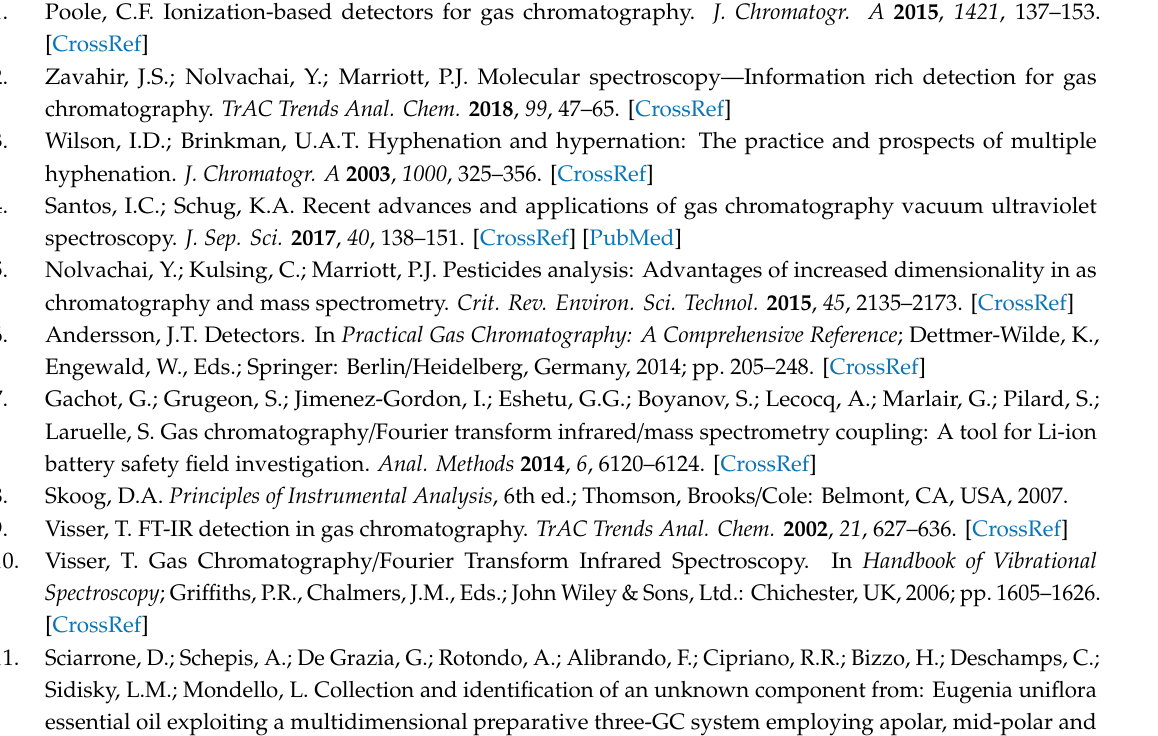
setup schematic for the light-pipe GC–FTIR–FID system., Figure S2: E ff ect of increasing light-pipe (and transfer line) temperatures on the root mean square intensity absorbance of GC–FTIR chromatograms of nonane., Figure S3: E ff ect of increasing LP and TL T , varying FTIR resolution and varying flow on signal-to-noise ratio calculations., Figure S4: GC–FTIR and GC–FTIR–FID chromatograms of 5% o -cresol in MeOH at varying injection volumes of (a) 1.5 µ L, (b) 2.0 µ L and (c) 3.0 µ L., Figure S5: Virtually identical GC–MS spectra for o -, m - and p -cresol isomers and their corresponding GC–FTIR spectra., Figure S6: GC–FTIR spectra of α -pinene, β -pinene, geraniol, γ -terpinene, limonene and eugenol essential oil standard compounds., Figure S7: GC × FTIR colour contour plot of acetaldehyde oxime (A.O.) and propionaldehyde oxime (P.O.) elution with FTIR spectra corresponding to P.O. isomers at di ff erent positions over the dynamic P.O. peak., Figure S8: Calibration curves for peak area of o -cresol and peak height of ethylbenzene and GC–FTIR spectra for o -cresol and ethylbenzene together., Figure S9: Calibration curves for α -pinene and γ -terpinene at their absorption maxima and maximum absorption peak responses of α -pinene and γ -terpinene., Table S1: Library match results for elution of compounds used for GC–FID and GC–FTIR–FID peak comparison., Table S2: Chromatography conditions for univariate calibration of select compounds depicted in Figure S8 and Figure